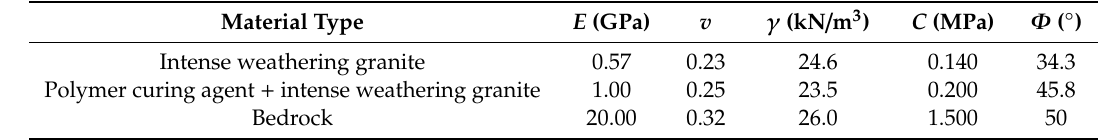
Table 1. Material parameters of slope model.